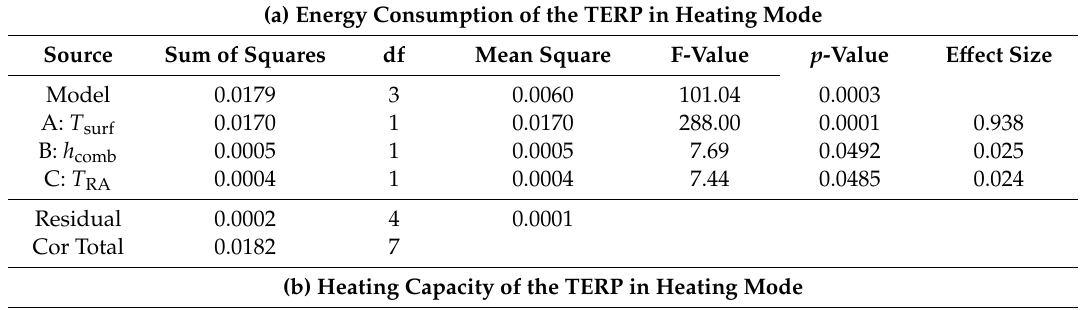
Table 6. ANOVA results of the developed empirical models.